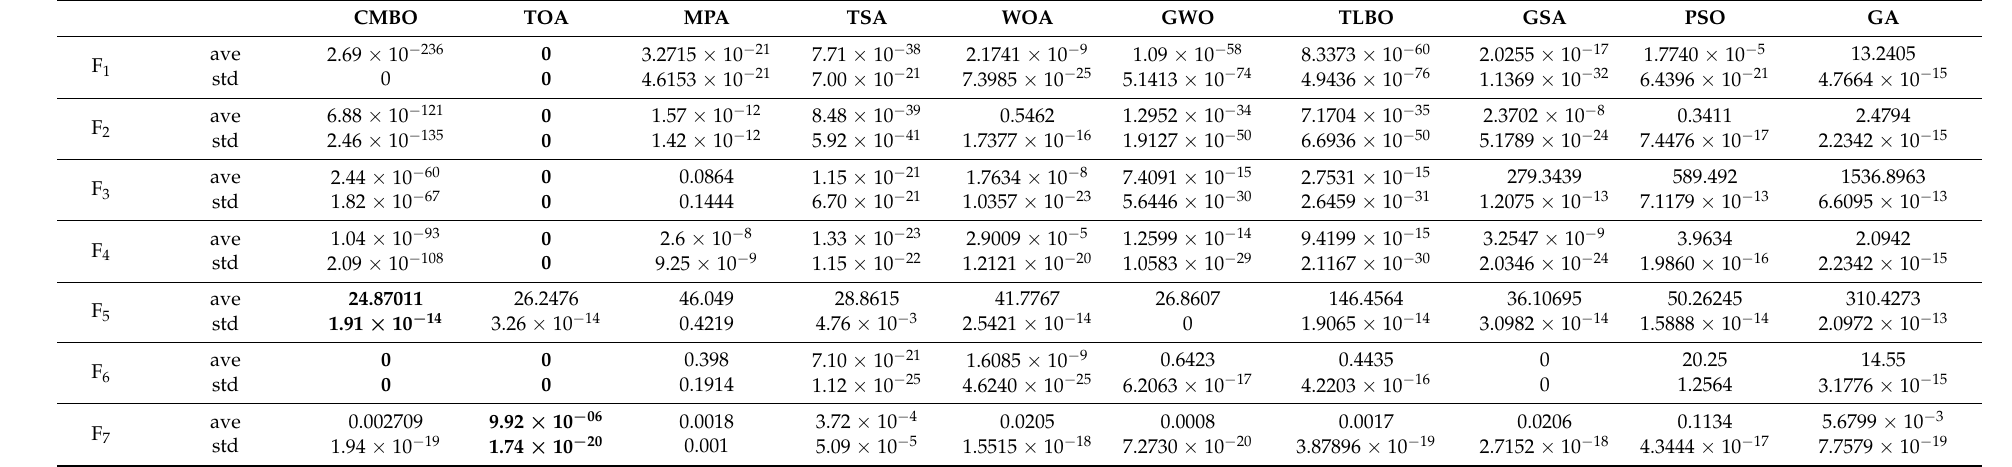
Table 4. Optimization results of CMBO and other algorithms on unimodal function.